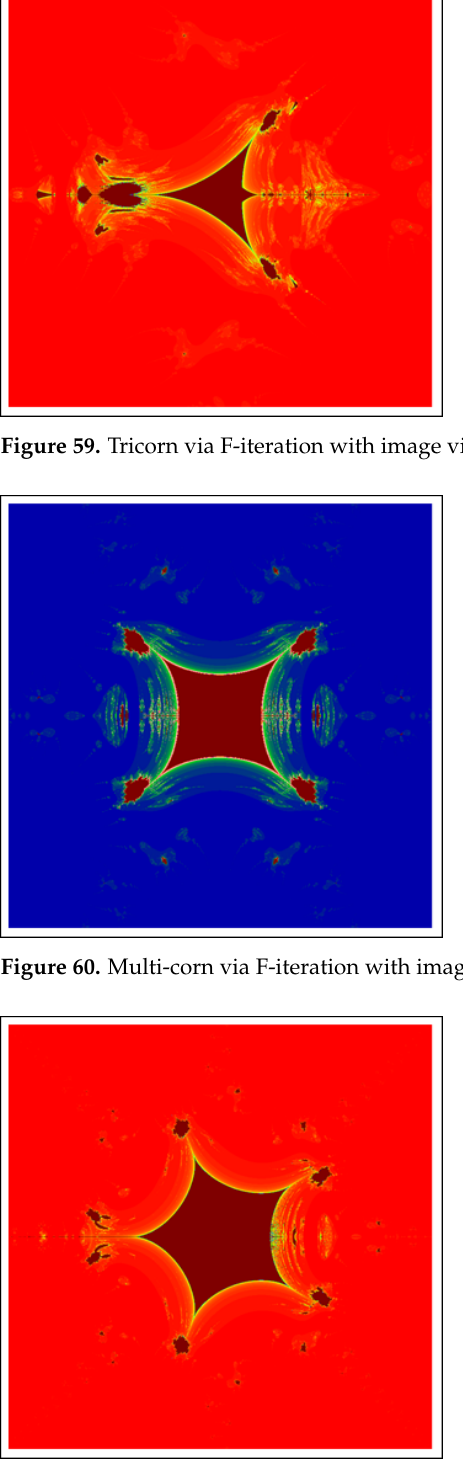
Figure 61. Multi-corn via F-iteration with image visual time = 155.1